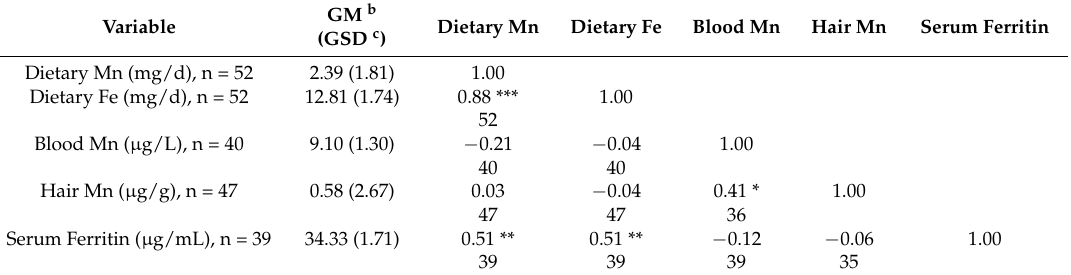
Table 2. Geometric mean, geometric standard deviation , and Pearson correlation coefficients matrix for dietary and biomarkers variables of Mn and Fe in CARES a from Guernsey County, OH, USA.